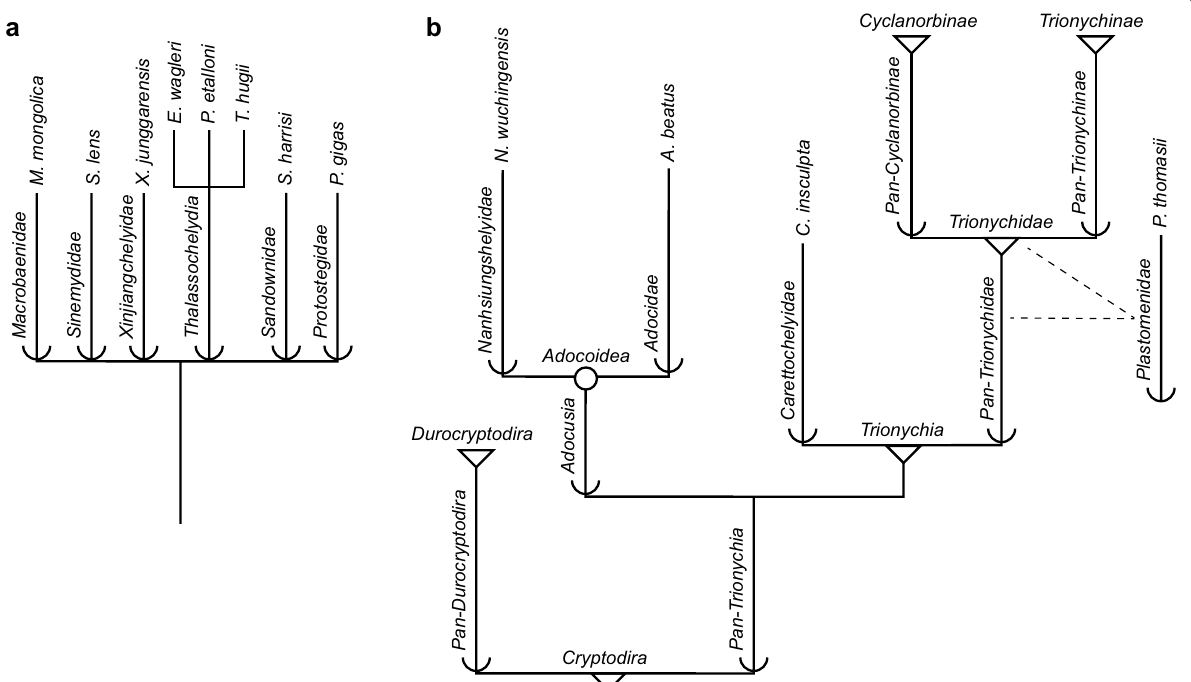
name/clade association was first codified by Lyson and Joyce (2011).